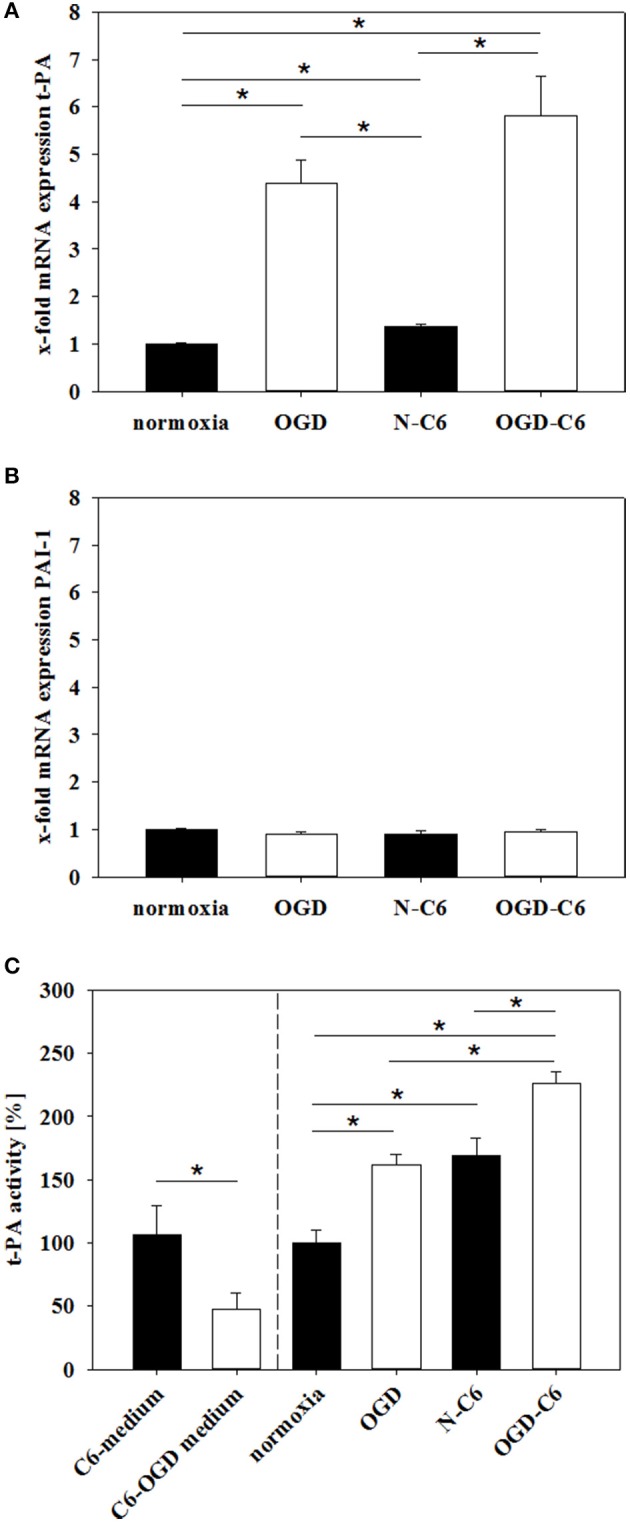
Influence of 4 h oxygen/glucose deprivation (OGD) treatment and presence of astrocyte soluble factors on mRNA expression of t-PA (A) and PAI-1 (B) of cerebENDs and t-PA activity in medium supernatants (C). For mRNA expression data: N, cerebEND normoxic control; OGD, cerebENDs treated under OGD conditions for 4 h; N-C6, cerebENDs treated for 4 h with C6 conditioned medium derived from C6 cells which were treated under normoxic control conditions for 4 h, OGD-C6, cerebENDs treated for 4 h OGD with C6 conditioned medium derived from C6 cells which were treated under OGD conditions for 4 h; for t-PA activity data: C6-medium, supernatants of C6 cells after 4 h normoxia; C6-OGD medium, supernatants of C6 cells after 4 h OGD; normoxia, supernatants of cerebEND cells after 4 h normoxia; OGD, supernatants of cerebEND cells after 4 h OGD; N-C6, supernatants of cerebEND cells after 4 h normoxia treated with C6-medium; OGD-C6, supernatants of cerebEND cells after 4 h OGD treated with C6-OGD medium. Statistical significance was labeled with *(p < 0.05, two-sided student's t-test with same variances). Data are presented as means ± s.e.m. (n = 6–8 for mRNA analysis, n = 3–13 for t-PA activity).